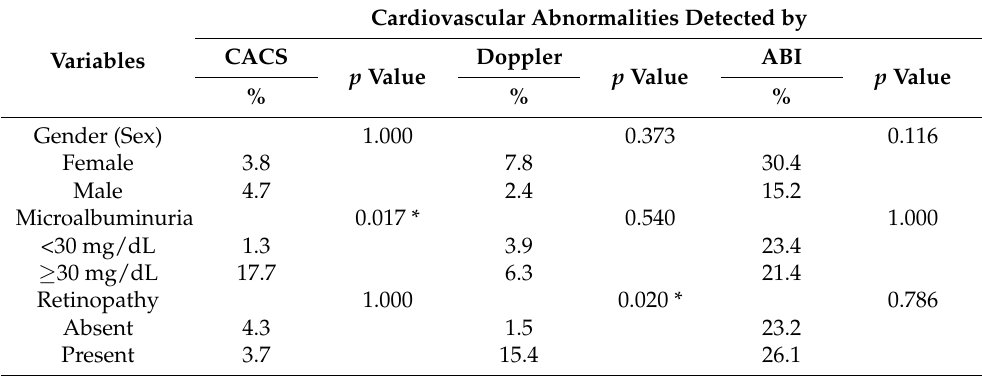
Table 3. Comparative analysis of cardiovascular abnormalities detected by different methods in type 1 diabetes patients according to sex, microalbuminuria, and retinopathy.